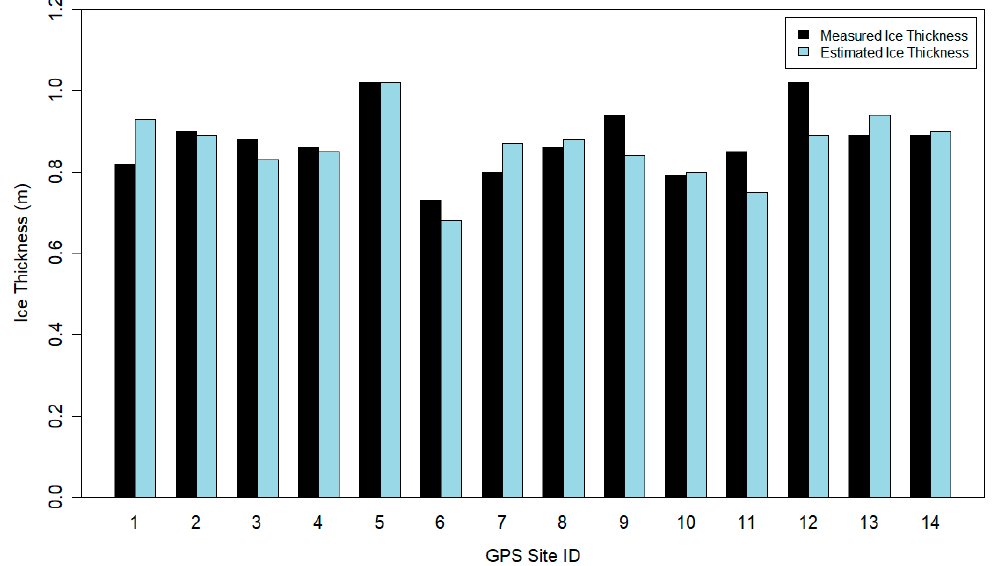
Figure 5. Comparison between estimated ice thickness from GPS-IR and measured ice thickness at each site location.